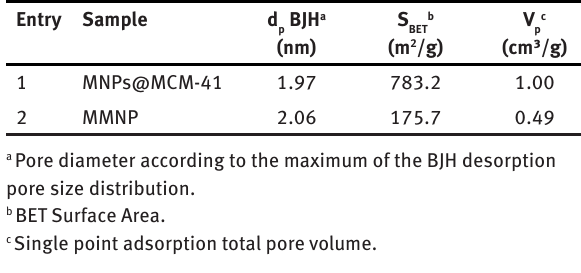
Table 2: Textural properties of MNPs@MCM-41 and MMNP